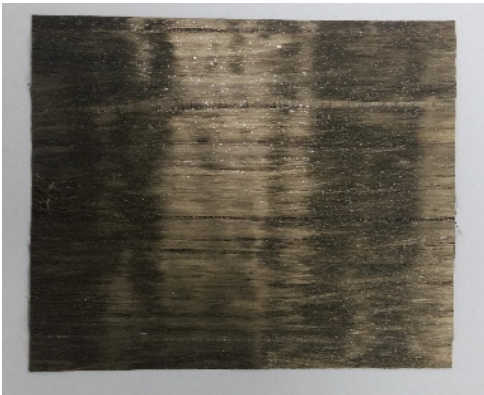
Figure 10 is a photograph of a 40- μ m metal-coated carbon fiber electromagnetic shielding film used in the test.